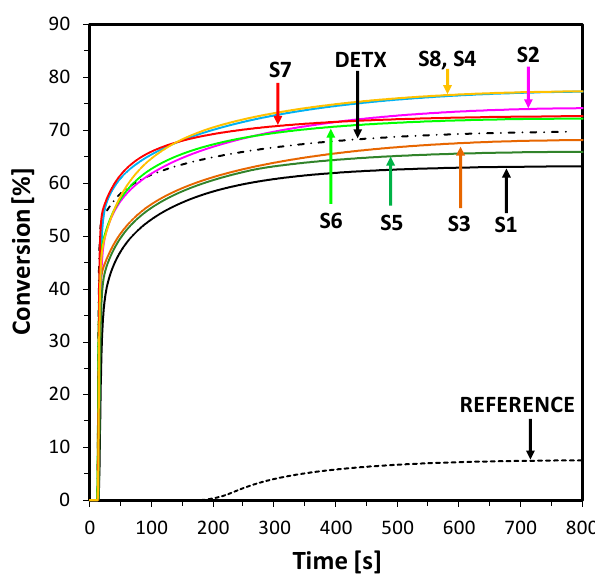
Figure 17. Polymerization rate profiles for photopolymerization of TMPTA with HIP (1 wt.%) and 2-amino-4,6-diphenyl-pyridine-3-carbonitrile derivatives (0.1 wt.%) under 405 nm LED (intensity at the surface of sample 25 mW/cm 2 ) irradiation, calculated from photo-DSC data. The irradiation starts at t = 10 s.